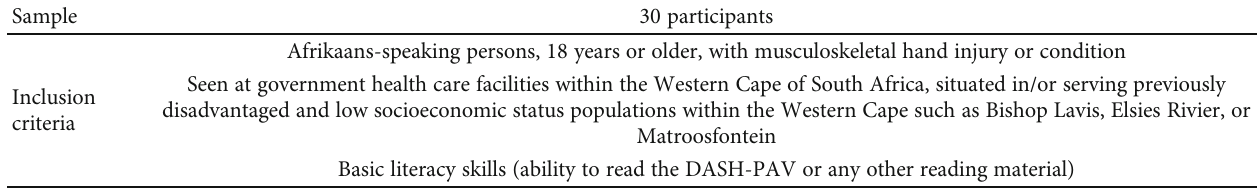
Table 2: Inclusion